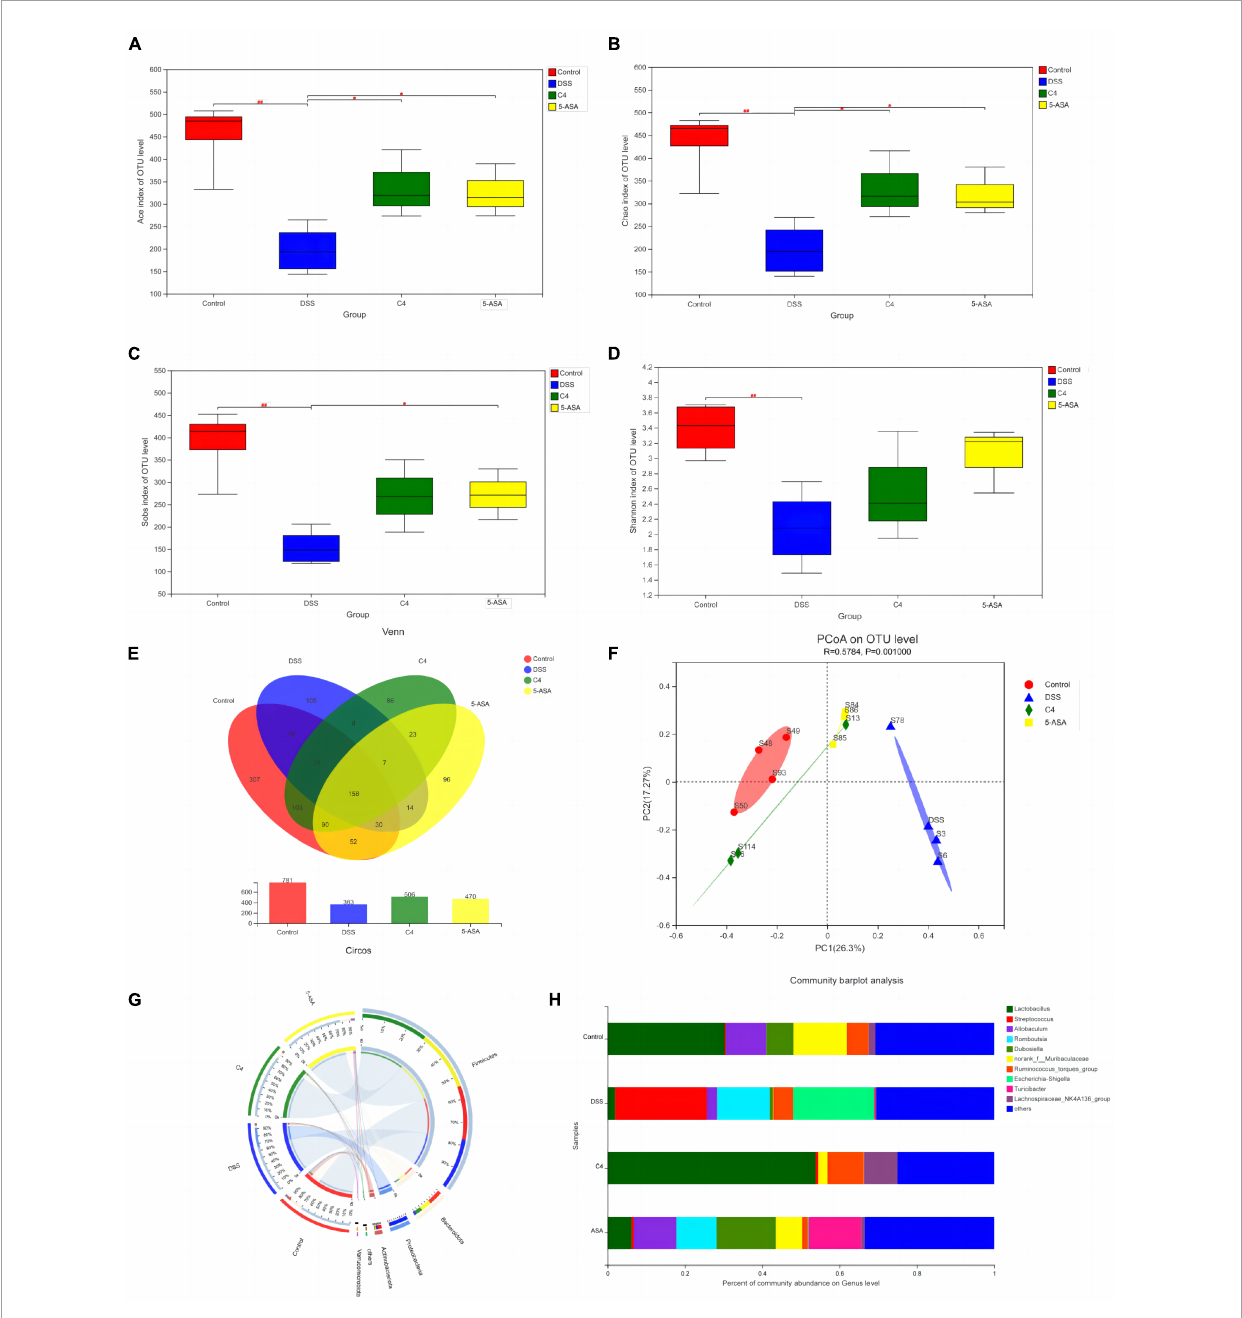
FIGURE3 Effect of the L. acidophilus C4 on the gut microbial environment. Data are subjected to one-way ANOVA statistics and presented as mean ± standard deviation ( n = 4). Three replicates were set for each group. (A–D) Alpha diversity of intestinal microbiota at the OTU level. (E) Venn diagram representing species composition analysis. (F) Beta diversity of intestinal microbiota. (G) Classification of intestinal microbiota composition at the phylum level. (H) Genus level gut microbiota bar graph analysis. * P < 0.05 vs. DSS group; ## P < 0.01 vs. Normal